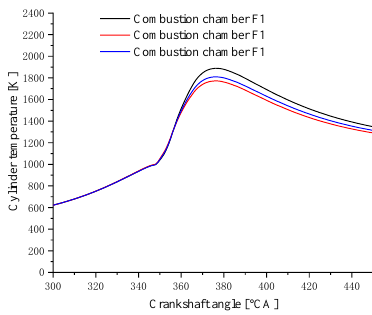
Figure 19. Comparison of cylinder temperature curves of three combustion chamber schemes matched with the 160° spray angle injector.